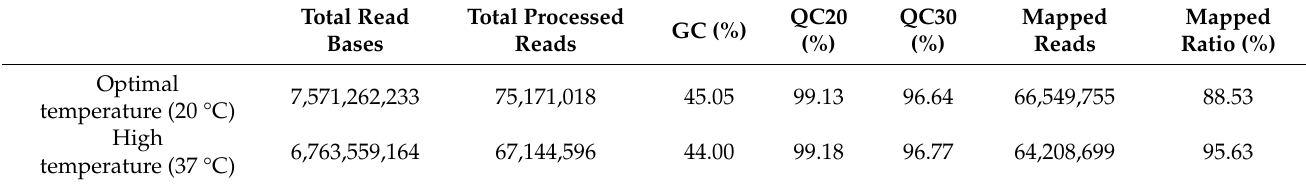
Table 1. Summary statistics of transcriptome analyses.